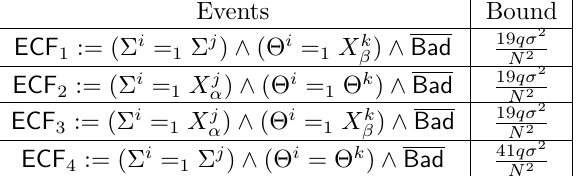
Table 4: Bound for the joint event (i) ECF 1 ∧ Bad (ii) ECF 2 ∧ Bad (iii) ECF 3 ∧ Bad and (iv) ECF 4 ∧ Bad